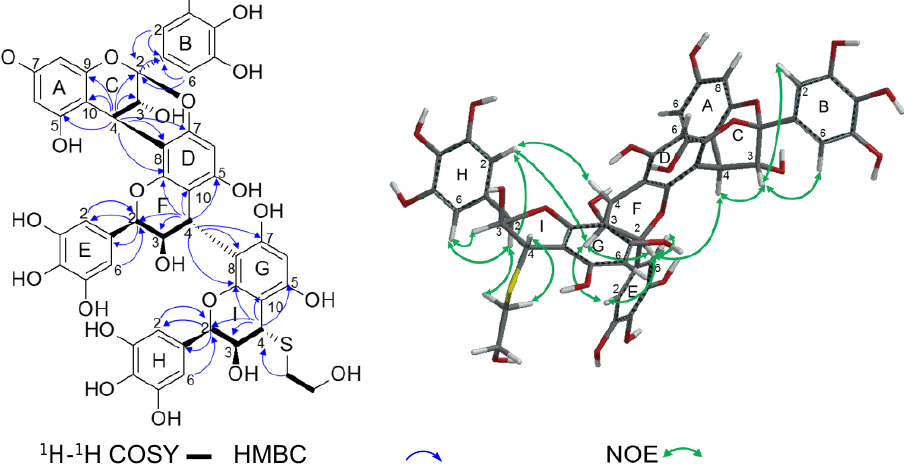
Figure 8. 1 H- 1 H COSY and HMBC correlations ( left ) and NOESY correlations ( right ) of 3 .